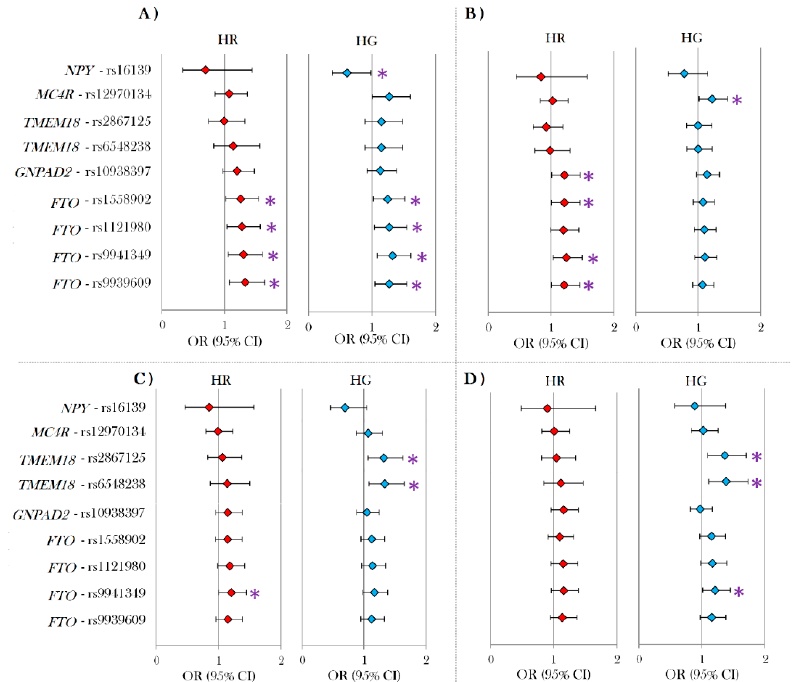
Figure 1. Odds ratios (ORs) of SNPs significantly associated with different obesity-related phenotypes for at least one study population. ( A ) OR for obesity (BMI < 25 vs. BMI ≥ 30); ( B ) OR for WC by ATPIII criteria; ( C ) OR for WC with IDF European criteria; ( D ) OR for WC with IDF Asian criteria. Nominally significant differences are marked with an asterisk (*).